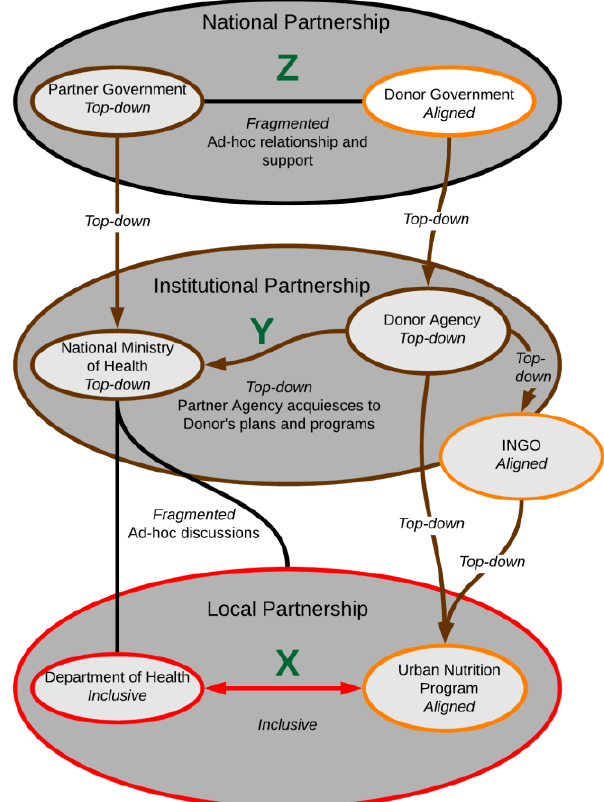
Figure 9. Partnership network in Inclusive state.